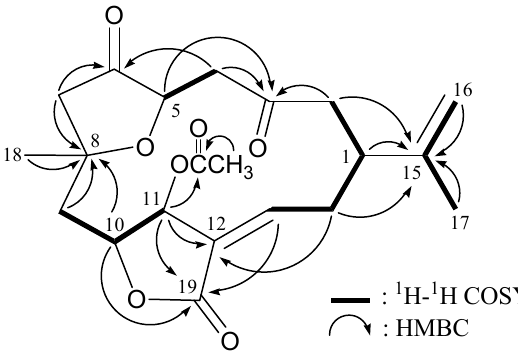
Figure 2. The 1 H– 1 H COSY and key HMBC (protons → quaternary carbons) correlations for 1 .